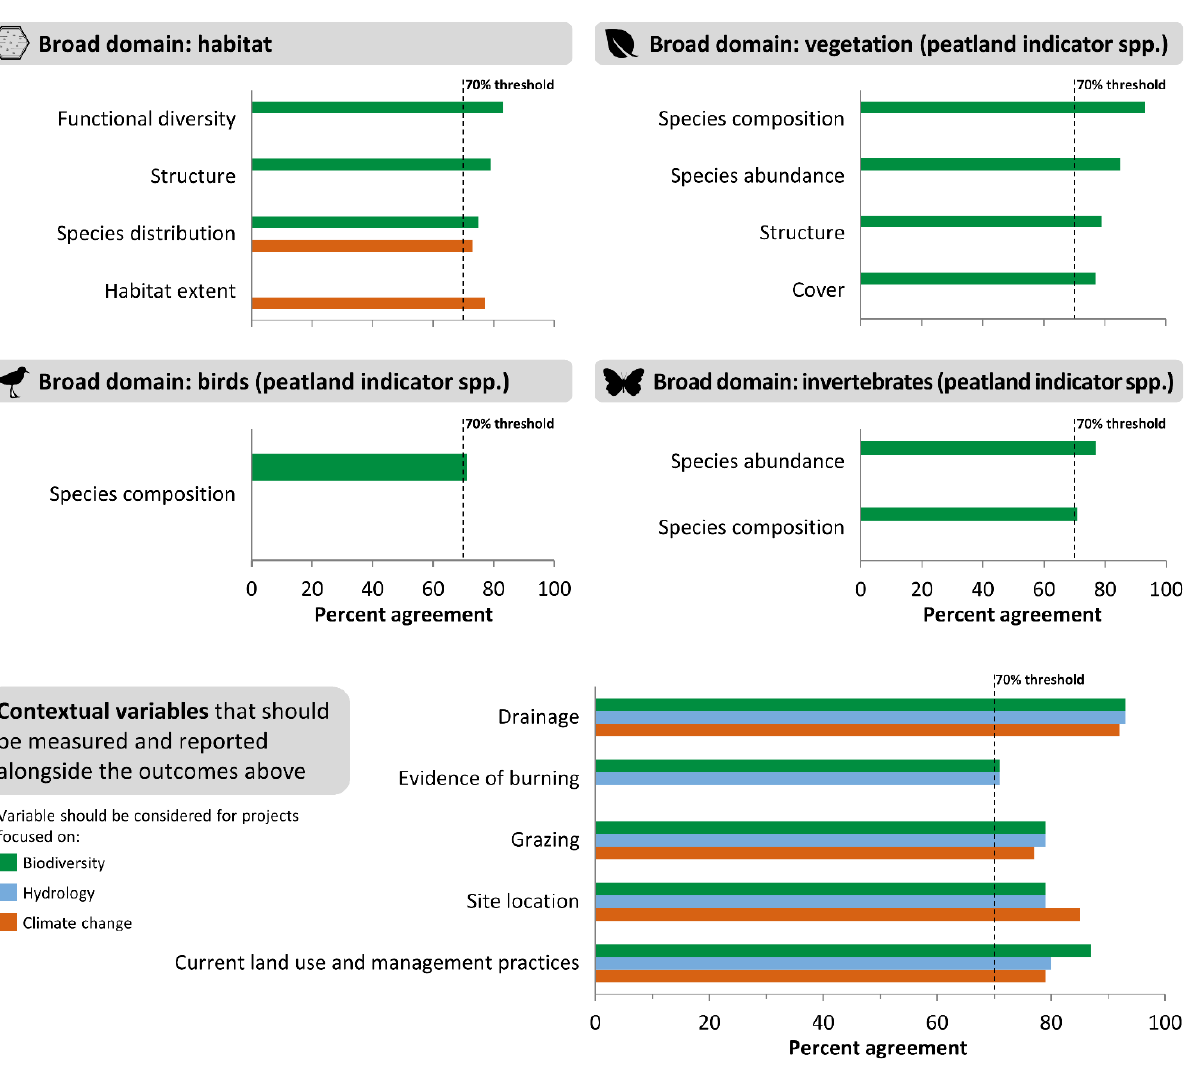
Figure 6. Biodiversity core domain set, and the constituent target domain outcomes agreed by ≥ 70 % of respondents as potential high priorities for measurement in UK peatland research or monitoring, depending on the objective or focus of the research or restoration project (based on 15 expert responses). Scores < 70 % are not shown. table depth; evidence of drainage networks; and hydraulic conductivity. Although there were many more fire-related outcomes identified for tropical peatlands, and an entire broad domain was dedicated to these, some were prioritised for measurement in both UK and tropical peatlands, including: time since burning; fire extent; and depth of burn (into